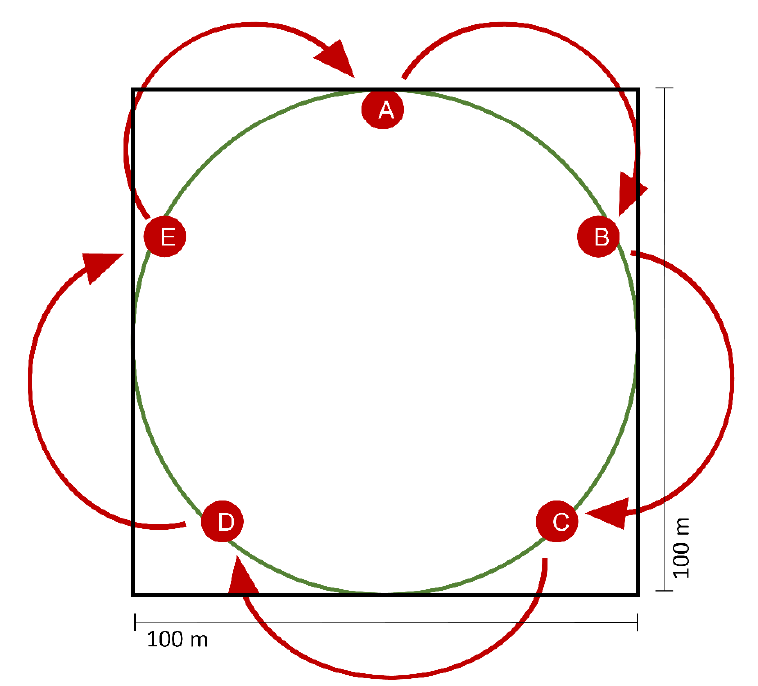
Figure 2. Location of five pitfall traps (A–E) on one forest plot (100 × 100 m). Traps were placed along the circumference of a circle with a maximal distance between each trap. For each baiting event, one specific treatment was positioned on a trap site, and at the next event, the treatment was rotated clockwise to the next trap position (shown as arrows) to avoid location effects.